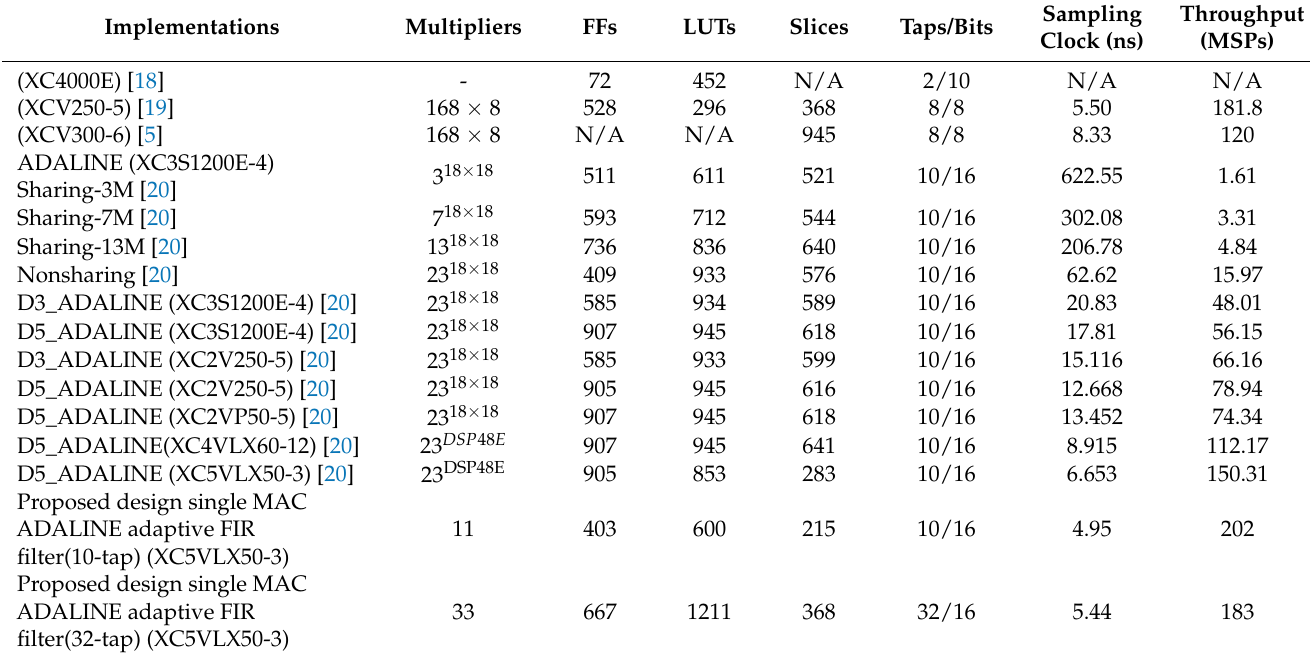
Table 2. Synthesis comparison of the existing system with the proposed